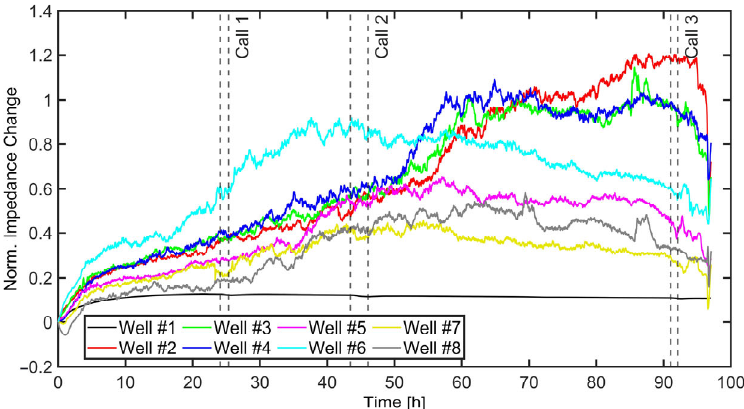
Figure 9. Results of normalized impedance measurements for the signal with f = 16 kHz, measured during 93 h of cell culture.